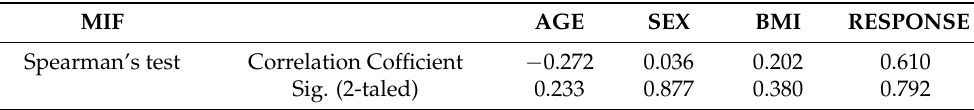
Table 2. Correlation between MIF and DLE clinical data.